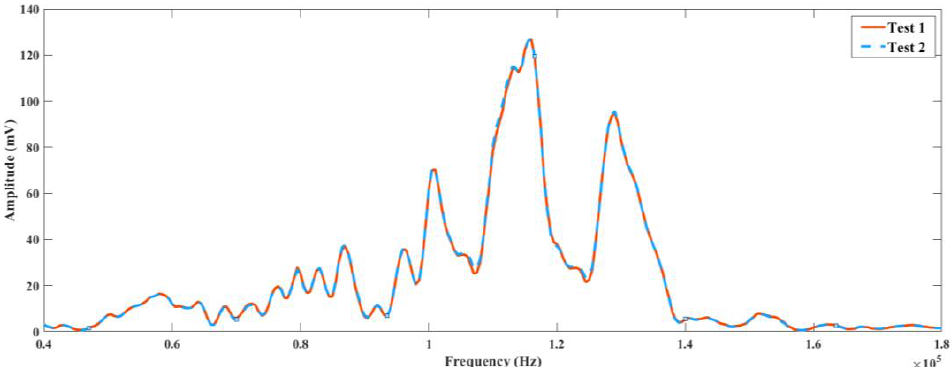
Figure 10. Spectrum of Sensor 1 of the part with 40% infill at two different times.